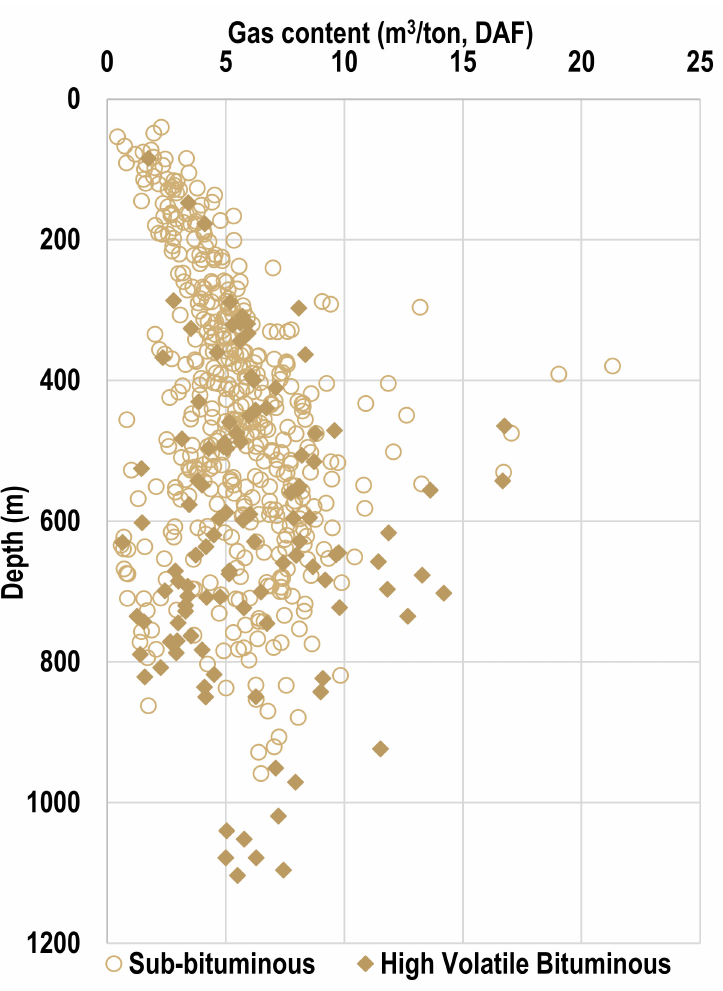
Figure 15. Gas content versus depth in the Surat Basin based on gas desorption data collected from 86 wells